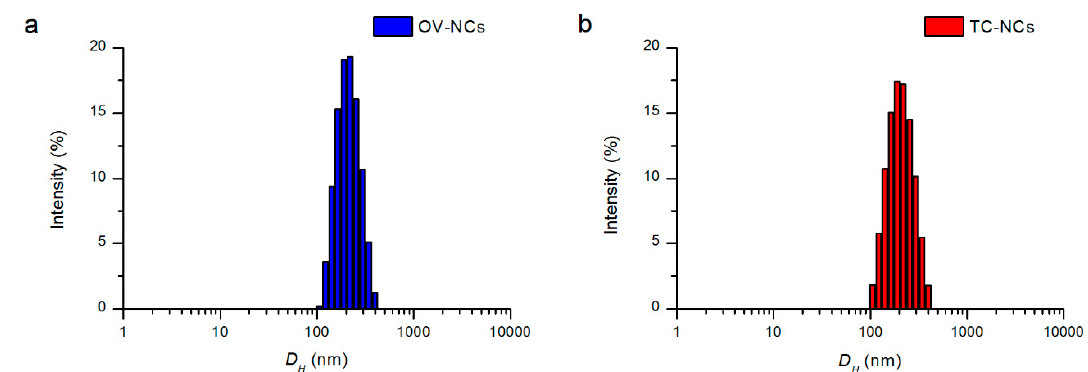
Figure 1. I-weighted distribution of the hydrodynamic diameter ( D H ) of ( a ) OV-NCs and ( b ) TC-NCs.